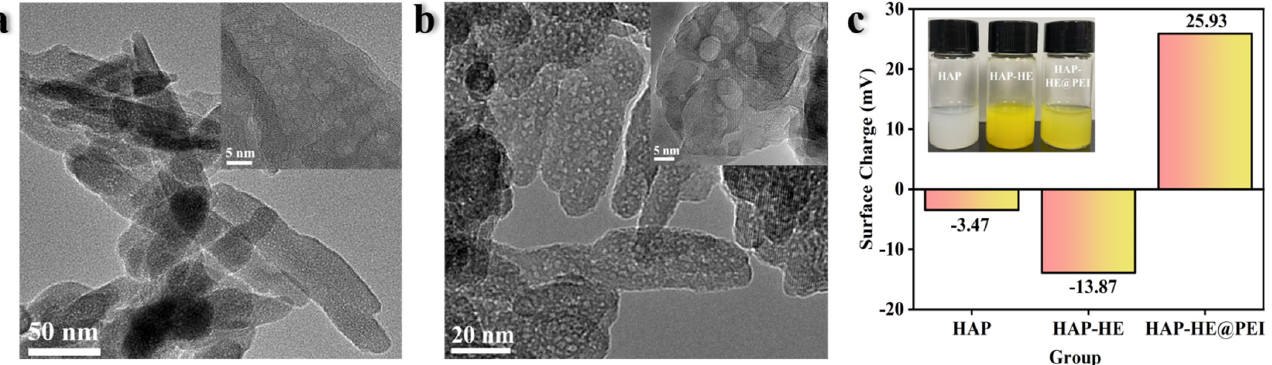
Figure 1. Representative TEM image of ( a ) HAP and ( b ) HAP − HE@PEI; ( c ) surface charge of HAP, HAP − HE and HAP − HE@PEI.